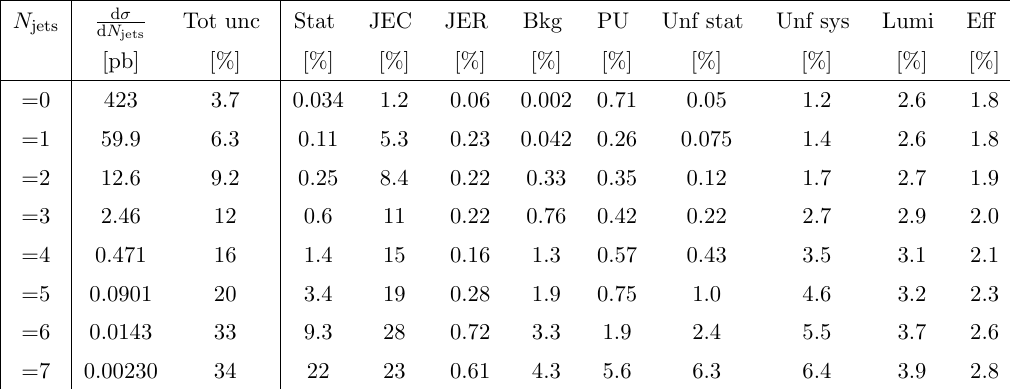
Table 1 . Cross section results obtained from the combination of the muon and electron channels as a function of the exclusive jet multiplicity and details of the systematic uncertainties. The column denoted Tot unc contains the total uncertainty; the column denoted Stat contains the statistical uncertainty; the remaining columns contain the systematic